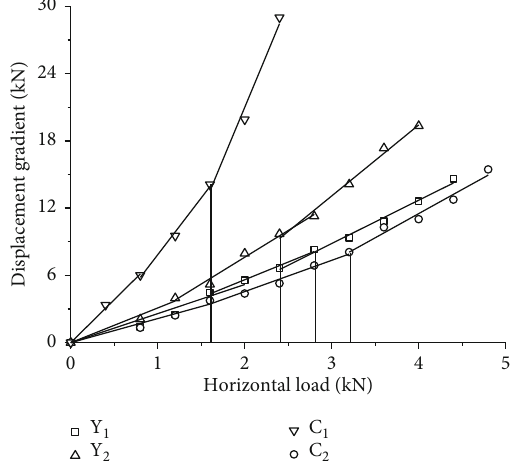
Figure 10: Horizontal load versus displacement gradient – Δ X ( H / Δ H 0 0 0